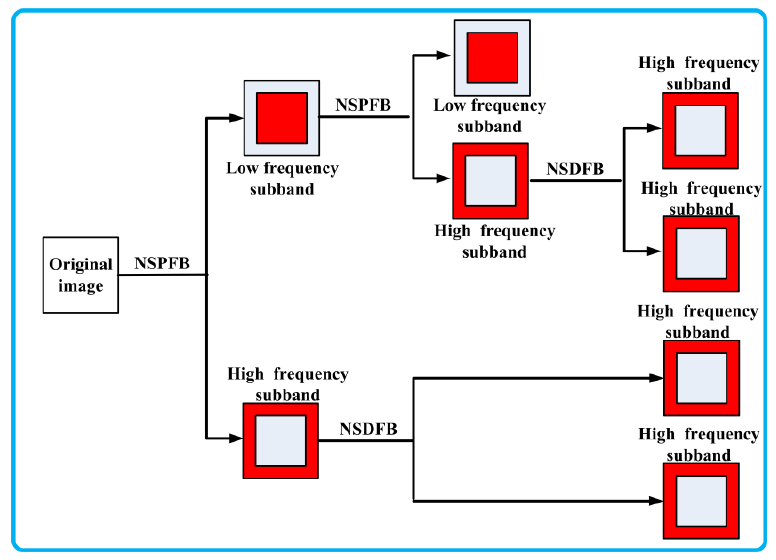
Figure 10. NSCT two-layer exploded chart. According to { H 1 , H 2 , . . . H s } and { L 1 , L 2 , . . . L s } obtained by NSCT, the image is divided into blocks using the sliding window technique, and the step size is set to s pixels to obtain q × q image blocks. (cid:8)